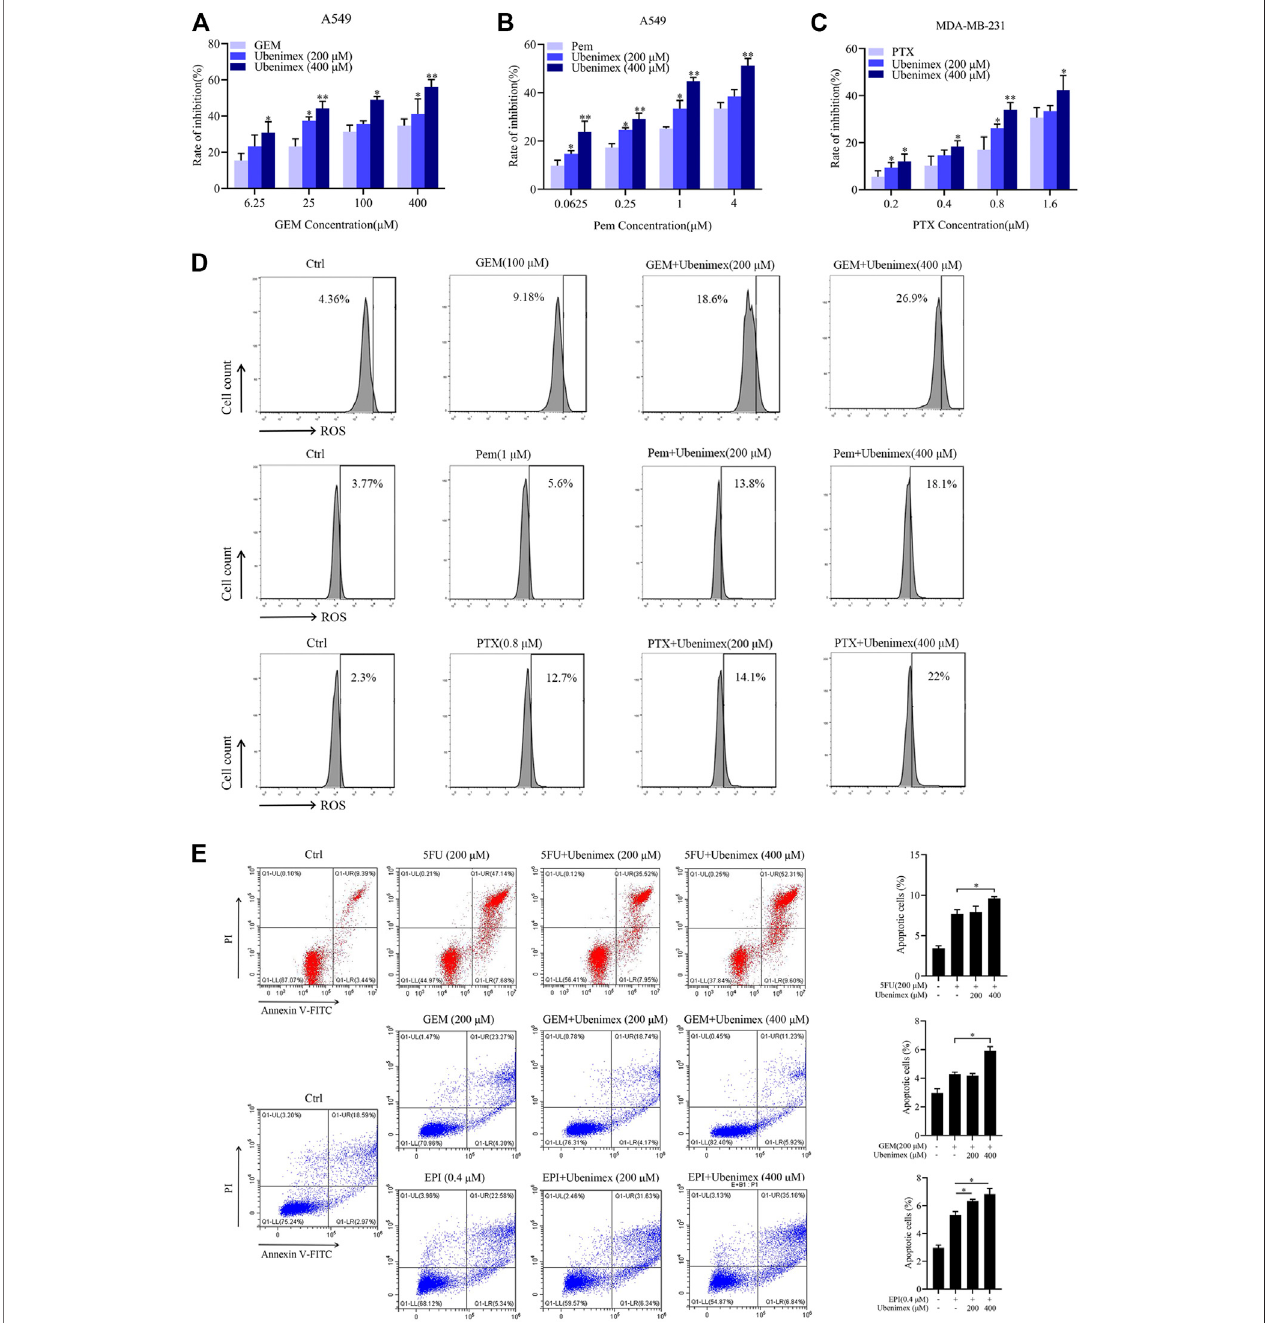
FIGURE 4 | CD13 inhibitor ubenimex enhances cytotoxicity of different chemotherapeutic drugs. (A – C) EdU assay on cell proliferation of A549 and MDA-MB-231 cells treated with GEM, Pem and PTX or combined with ubenimex for 48 h. (D) A549 and MDA-MB-231 cells were treated with GEM, Pem, and PTX or combined with ubenimexfor48 h,thelevelsofROSdetectedby fl owcytometry.ArepresentativeROSlevelfromthreeindependentexperimentsgivingsimilarresultsisshown. (E) Flow cytometric analysis of cell apoptosis induced by a chemotherapeutic drug and ubenimex combination in PLC/PRF/5 cells using annexinV-FITC/PI. Data are presented as mean ± SEM ( n (cid:2) 3), * p ≤ 0.05, ** p ≤ 0.01.